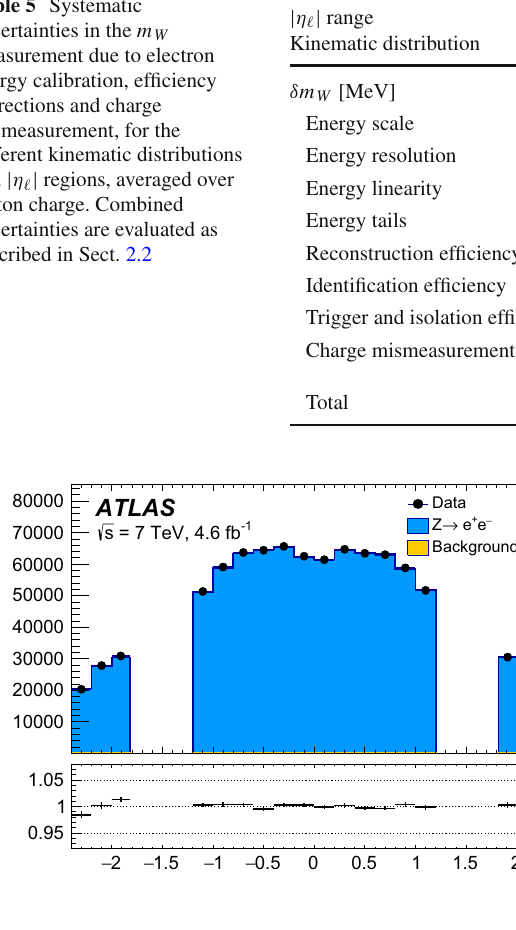
Fig. 10 Distribution of reconstructed electrons η in Z → ee events. The data are compared to the simulation including signal and back- ground contributions. Corrections for energy resolution, and for recon- struction, identification, isolation and trigger efficiencies are applied to the simulation; energy-scale corrections are applied to the data. Back- ground events contribute less than 0.2% of the observed distribution. The lower panel shows the data-to-prediction ratio, with the error bars showing the statistical